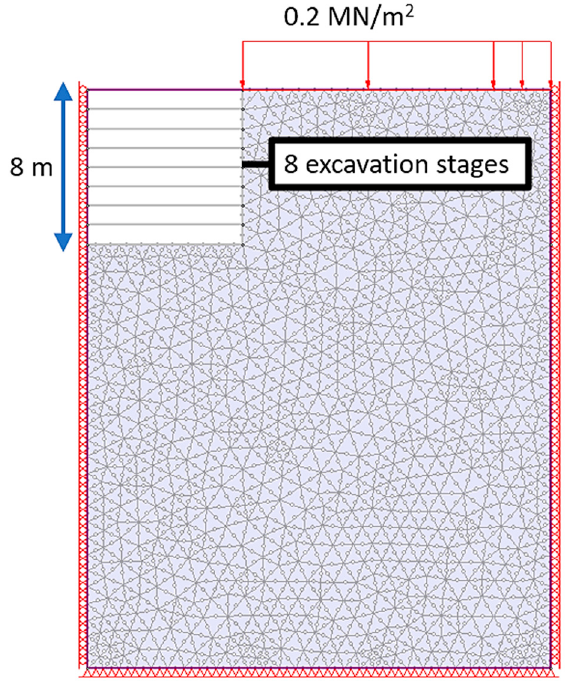
Figure 3. Vertical excavation model geometry.